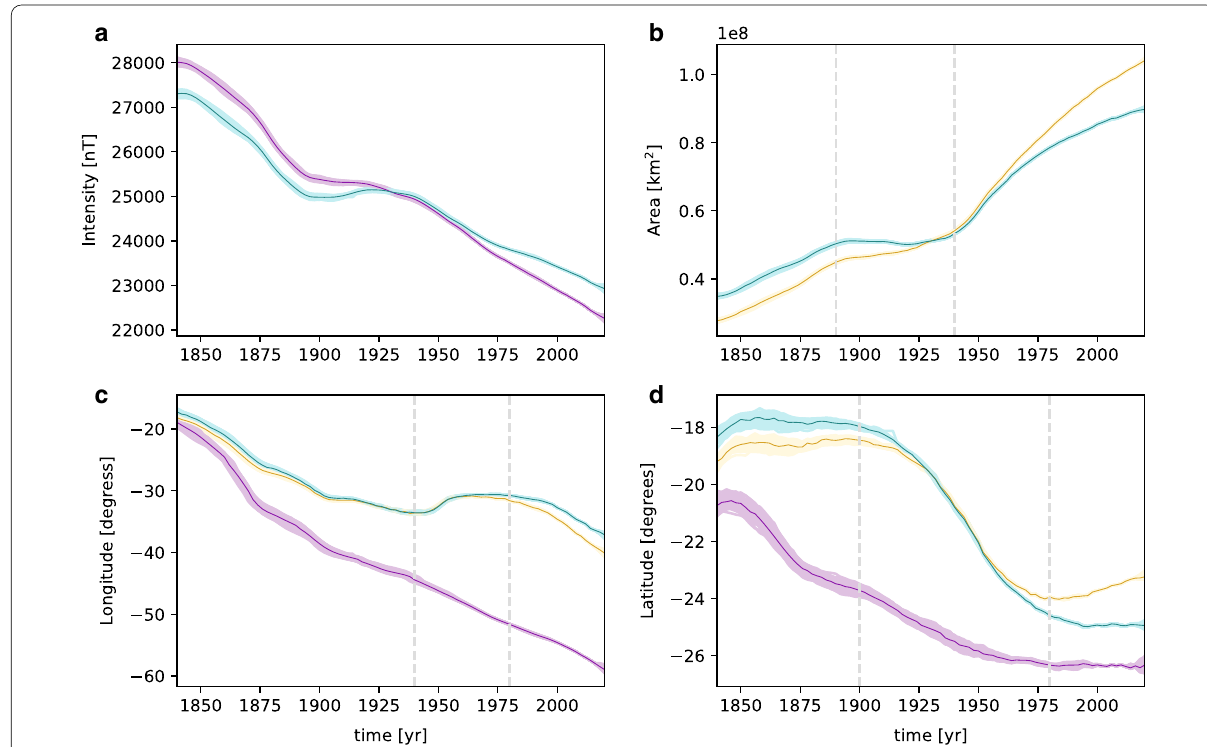
Fig. 4 SAA characterization vs. time for the period 1840–2020. Dark lines denote the mean model of COV‑OBS.x1, light envelopes denote the 100 realizations of the ensemble. a Minimum intensity (purple) and the relative minimum intensity |� B | rel min (turquoise). b Area based on S 0 (yellow) and S 1 (turquoise). c Longitude of center based on Min (purple), CM0 (yellow) and CM 1 (turquoise). d Latitude of center based on Min (purple), CM0 (yellow) and CM1 (turquoise). Vertical dashed lines highlight special events of SAA area decrease ( b ), SAA center eastward drift ( c ) and SAA center rapid southward drift ( d ) Table 1 Mean rates of change of the SAA area in 10 5 km 2 / year and of the coordinates of its center in ◦ /year for all models